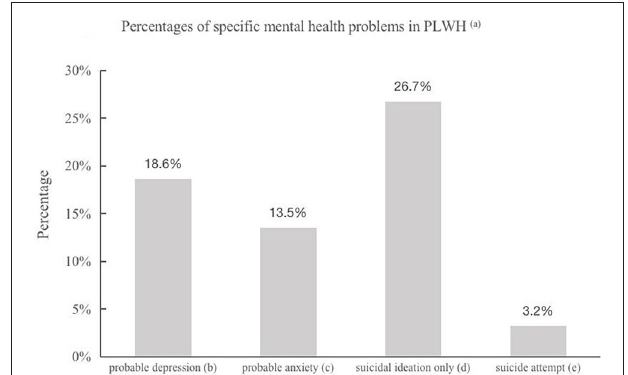
FIGURE 1 | (a) PLWH: People Living With HIV. (b) Probable depression was defined as having a score ≥ 10 on Patient Health Questionnaire (PHQ-9). (c) Probable anxiety was defined as having a score ≥ 10 on the Generalized Anxiety Disorder Scale (GAD-7). (d) Participants who reported suicidal ideation without suicide attempt after HIV/AIDS infection. (e) Participants who reported occurrence of suicide attempt(s) after HIV/AIDS infection.